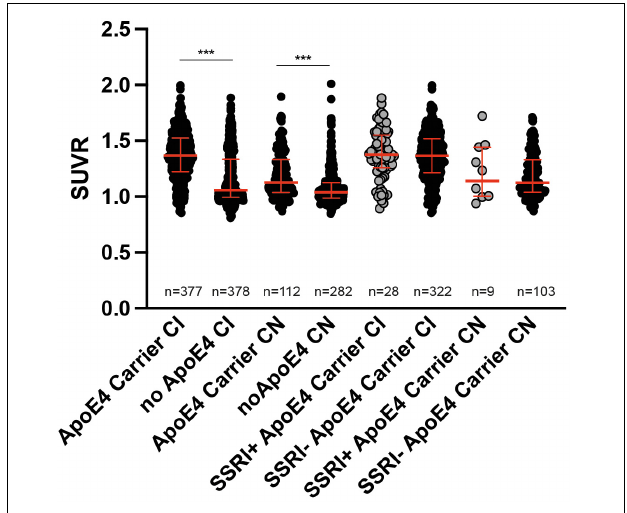
FIGURE 6 | ApoE4 carriers. ApoE4 carriers showed significantly higher SUVR compared to non-carriers in cognitively impaired patients as well as in cognitively normal subjects (Mann–Whitney U test; *** p < 0.001). There were no differences between ApoE4 carriers in SSRI + and SSRI − groups (Mann–Whitney U test). Red bars represent median ± interquartile